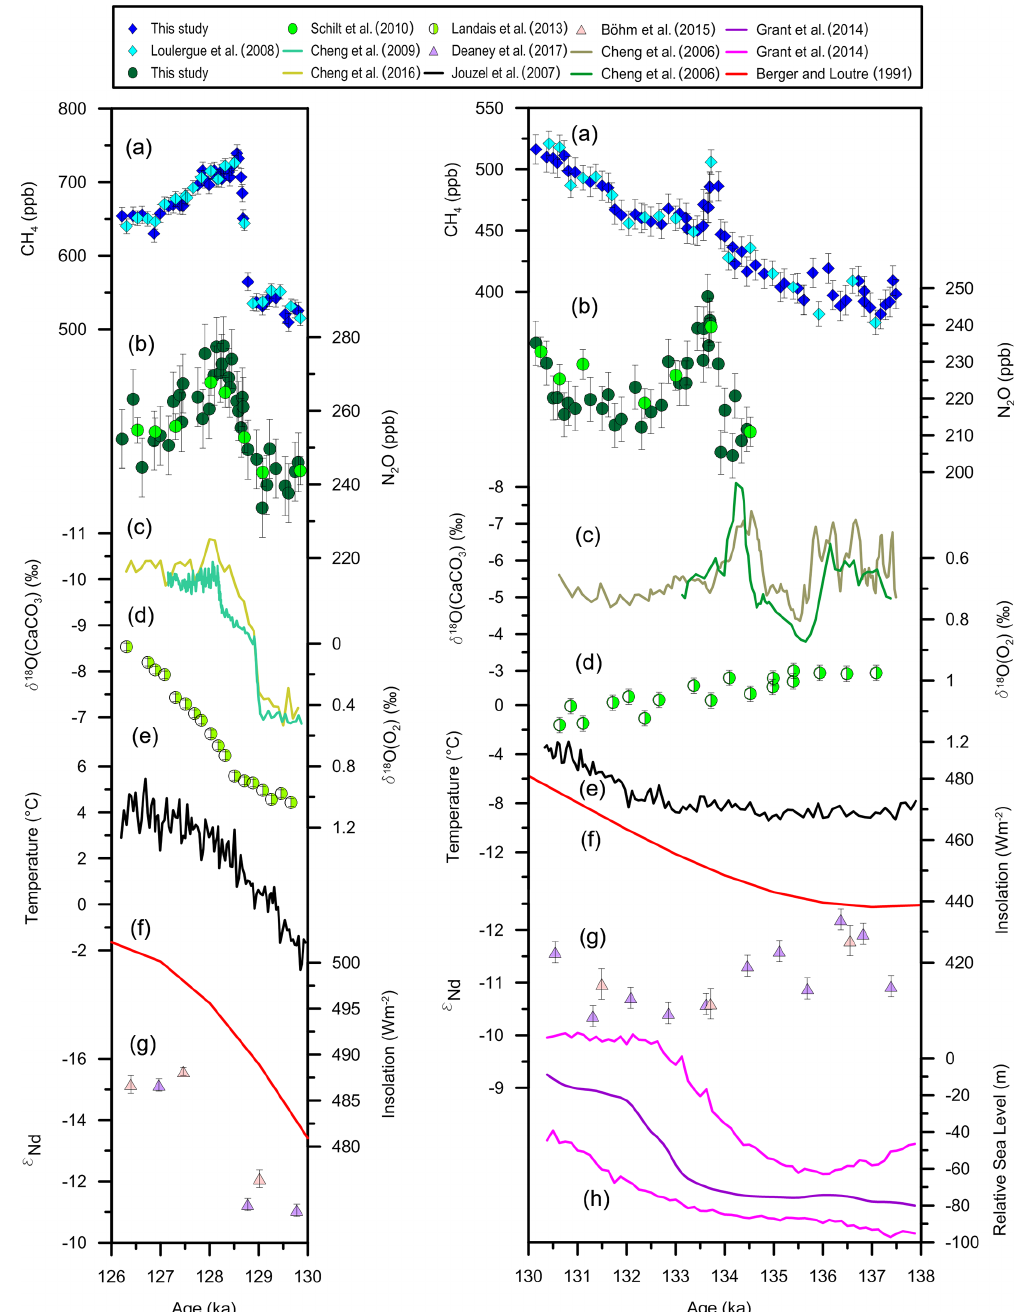
Figure 3. Details of the 129 (left panel) and 134ka events (right panel). (a) Composite CH 4 record. (b) Composite N 2 O record. (c) Speleothem δ 18 O (CaCO 3 ) records: Sanbao SB25 (light green) (Cheng et al., 2009), Hulu Cave MSX (khaki) (Cheng et al., 2006), Hulu cave MSP (dark green) (Cheng et al., 2006), and Sanbao–Dongge composite (pale yellow). (d) δ 18 O (O 2 ) from EDC on the AICC2012 timescale (Landais et al., 2013). (e) Antarctic surface temperature (relative to the last millennium) from EDC on the AICC2012 timescale (Jouzel et al., 2007). (f) Mean summer (June to August) insolation at 40 ◦ N (Berger and Loutre, 1991). (g) Composite ε Nd from the sediment core ODP Site 1063 (Deaney et al., 2017), including data points from Böhm et al. (2015) (purple) and new measurements from Deaney et al. (2017) (pale pink), on the timescale of Deaney et al. (2017). (h) Relative sea level stand from the Red Sea synchronized on a radiometric timescale, including the maximum probability curve (purple) and its 95% confidence interval (magenta) (Grant et al., 2014).